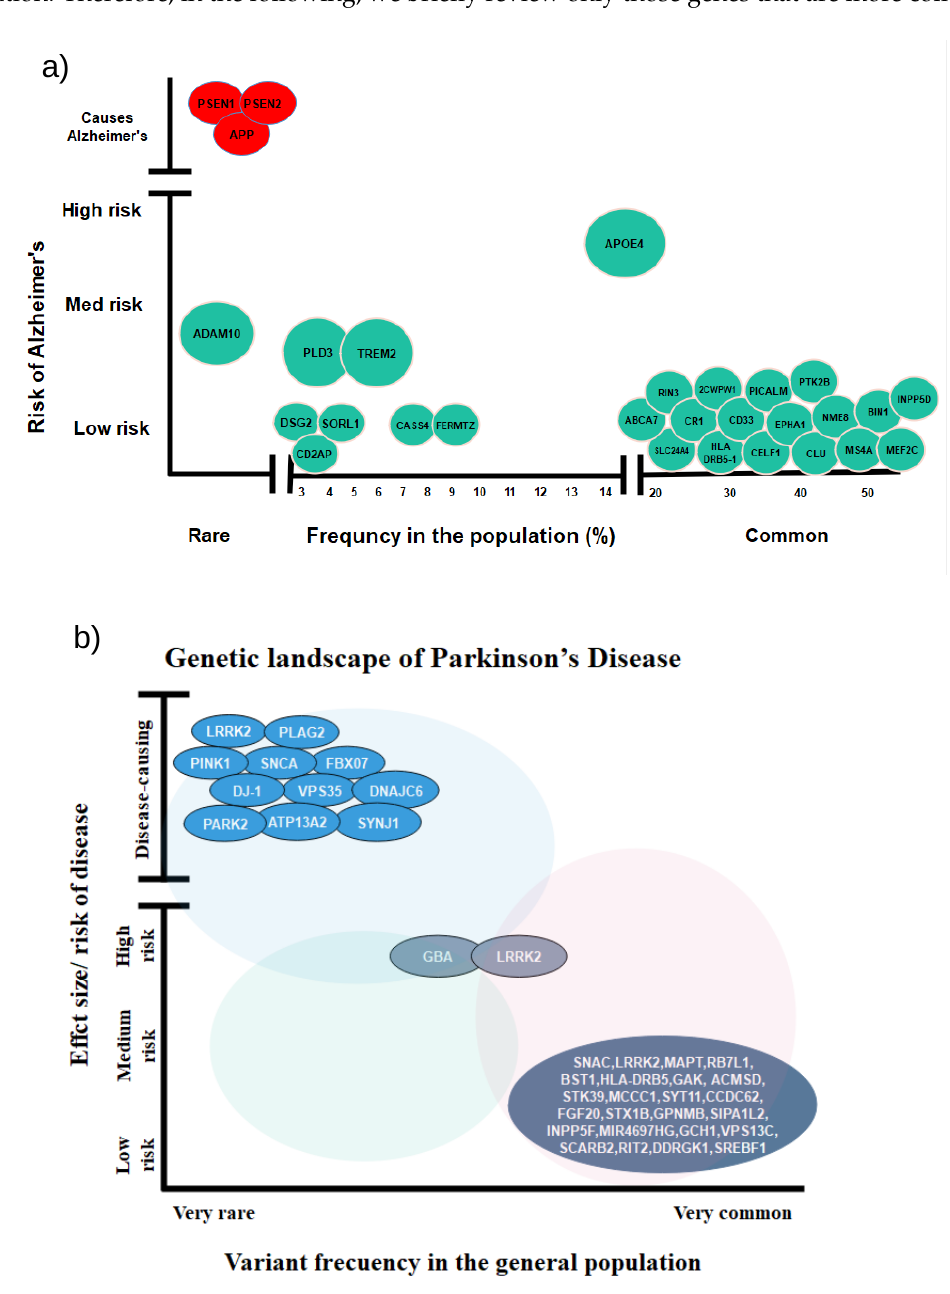
Figure 1. ( a ) Rare and common variants of AD genes and their risk. Red color signifies Mendelian genes, and green signifies non-Mendelian genes (adapted from [15]). ( b ) Rare and common variants of PD genes and their risk (adapted from